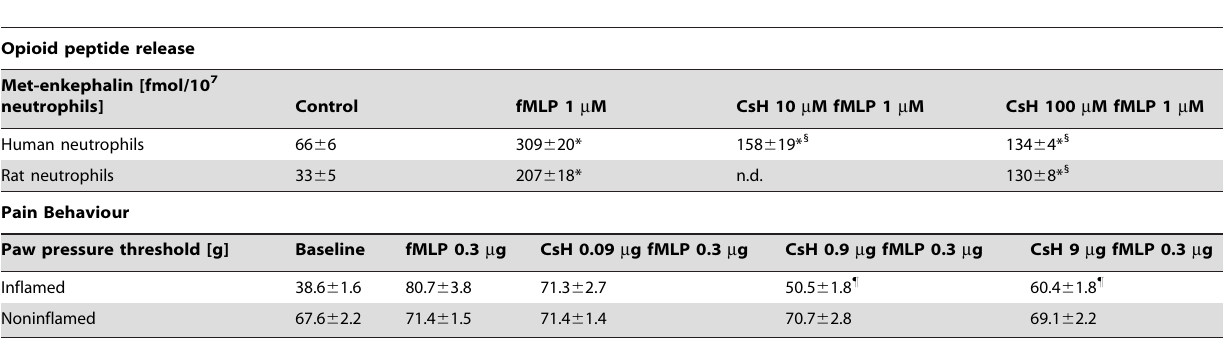
Table 1. Effect of the FPR antagonist cyclosporine H (CsH) on fMLP-induced Met-enkephalin release from neutrophils and on fMLP-induced antinociception.